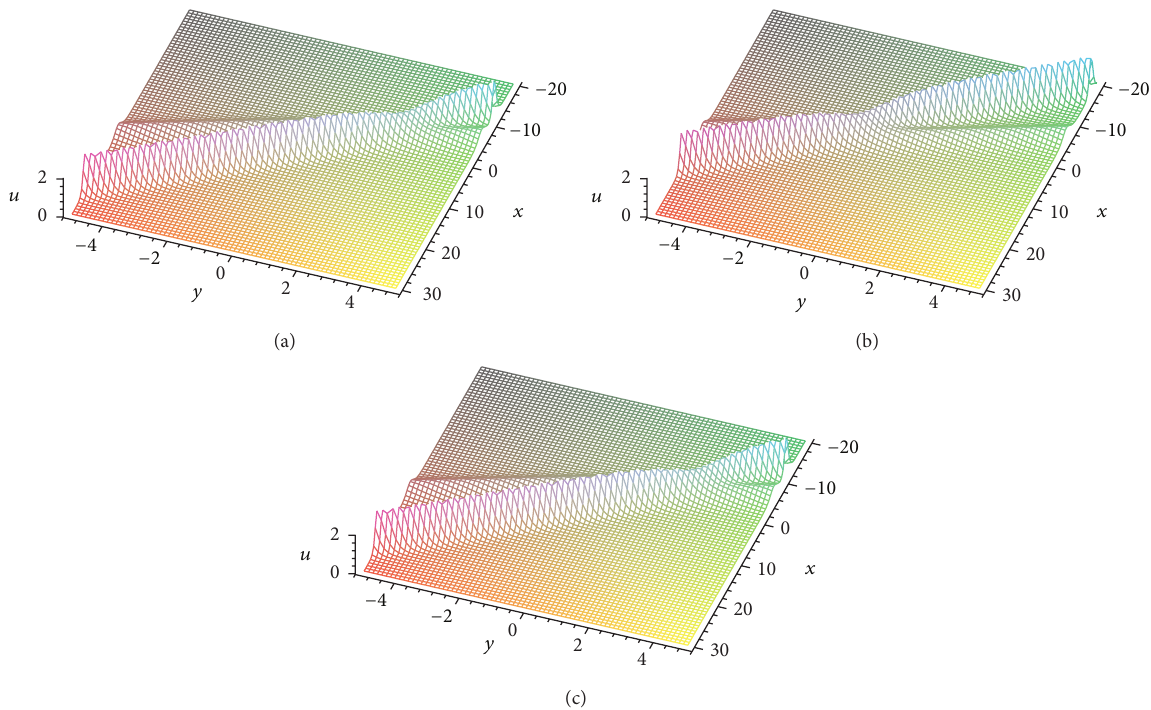
Figure 3: Two-soliton solution via solution (33) with 𝑎 9 = 0.01 , 𝑘 1 = 1 , 𝑘 2 = 2 , 𝑙 1 = 2 , 𝑙 2 = 7 , 𝑐 0 = 1 , 𝑐 1 = 0.02 , 𝑎 1 = 𝑡 , and 𝜉 1 = 𝜉 2 = 0 . (a) 𝑡 = −0.8 ; (b) 𝑡 = 0 ; (c) 𝑡 = 0.8